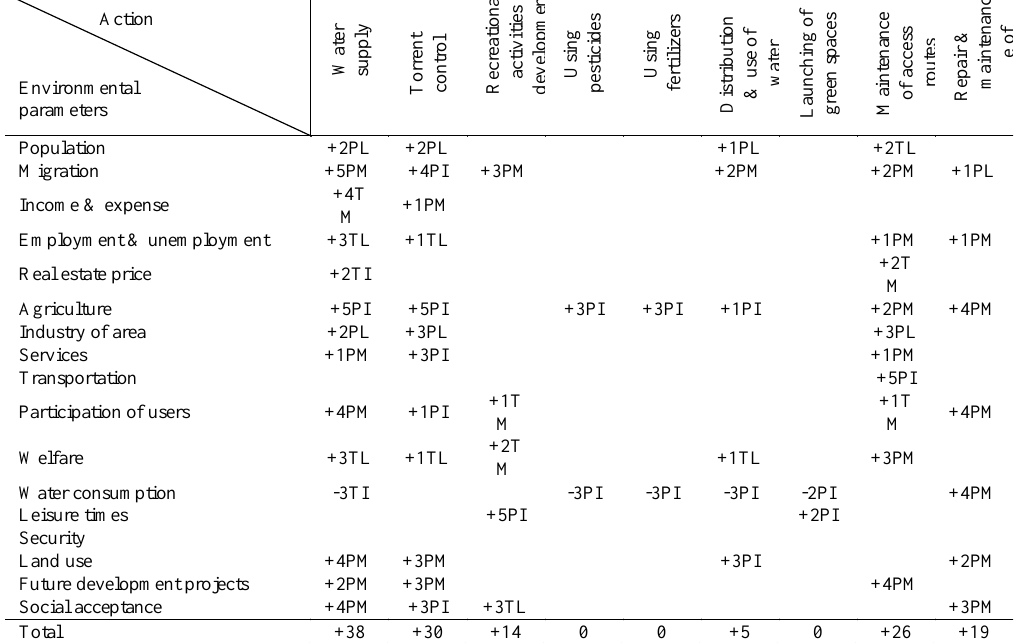
Table 8: Prediction matrix of socio-economic impact s of irrigation and drainage network in operation